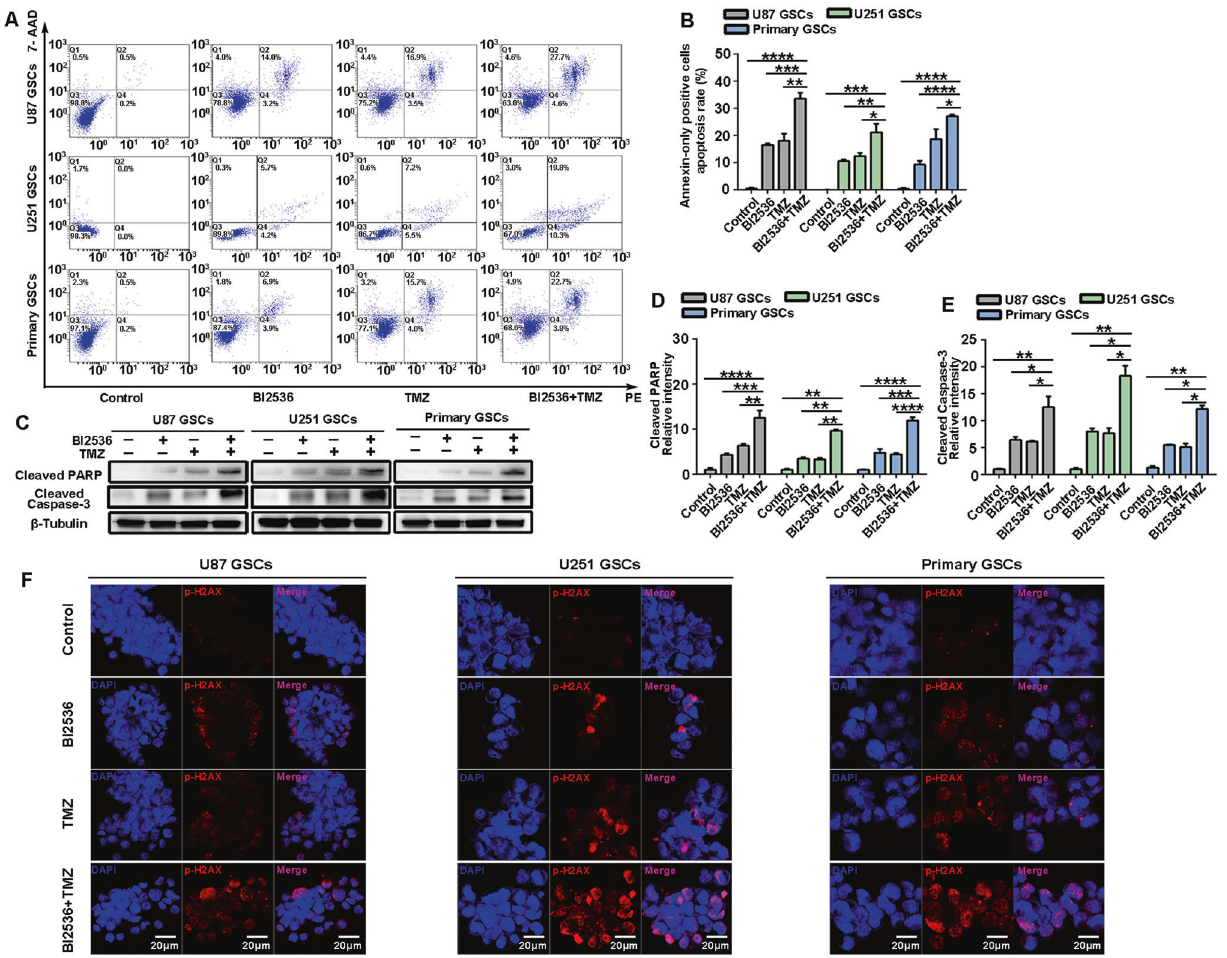
Fig. 3 PLK1 inhibition can synergize TMZ-induced apoptosis and DNA damage in GSCs. U87, U251, and primary GSCs were treated with BI2536, TMZ, or both for 24 h. A Flow cytometry assay showed the apoptosis of GSCs. B Statistics of annexin-only positive GSCs apoptosis rate. C – E Expression of cleaved PARP and cleaved Caspase-3 was detected by Western blot. F Cells were immunostained for γ -H2AX (red) and DAPI (blue). Scale bar = 20 μ m. Data in B , D , and E are shown as means ± SD, n = 3, #P = NS, * P < 0.5,** P < 0.1, *** P < 0.001, **** P < 0.0001, Student ’ s t